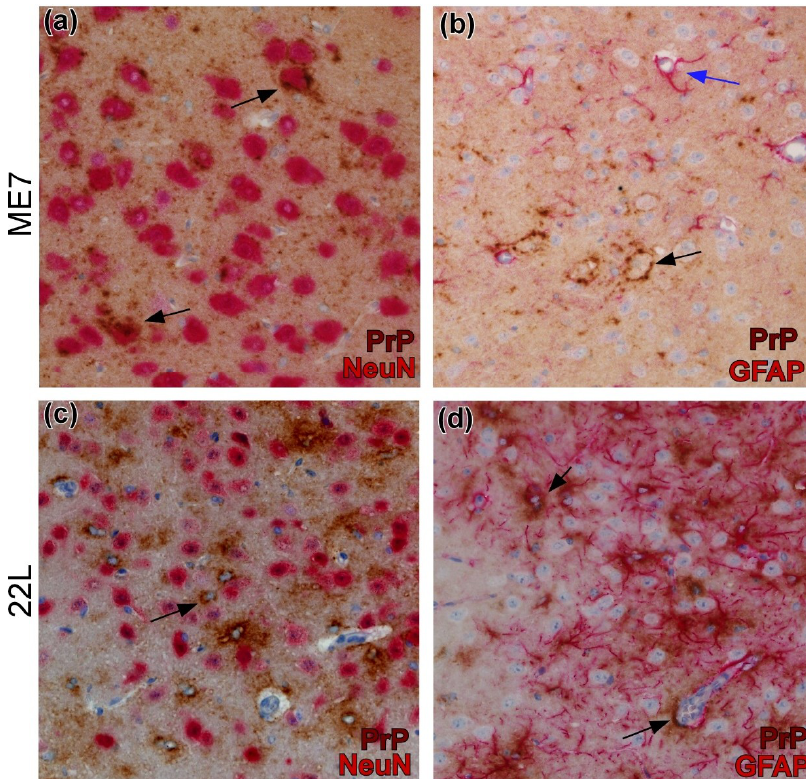
Figure 5. Use of dual-staining immunohistochemistry for detection of PrPSc from scrapie strains ME7 and 22L associated with neurons or astrocytes in brain. ( a ) PrPSc (brown) surrounds ME7-infected neurons (arrows) in amygdala that are detected by anti-NeuN (red). ( b ) In hypothalamus, ME7 PrPSc surrounds neuronal cell bodies (black arrow). Astrocytes detected by anti-Glial Fibrillary Acidic Protein (GFAP) (red) have no PrPSc and are not infected (blue arrow). ( c ) PrPSc (brown)-expressing 22L-infected cells (arrow) are distinct from NeuN-stained (red) neurons in thalamus. ( d ) PrPSc (brown) expressing 22L-infected cells (arrows) are associated with GFAP-stained (red) astrocytes in thalamus.